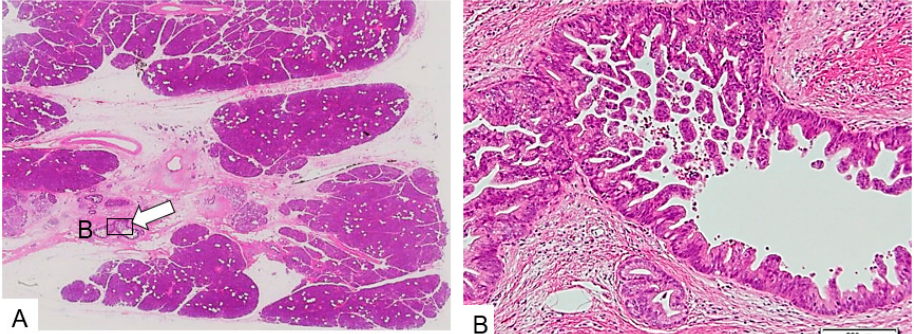
Figure 5. Hypoecho stricture type. ( A ) Histopathological specimen does not show the severely collapsed main pancreatic duct (arrow). Surrounding parenchyma becomes atrophic and is partially replaced by fat tissue. The main and the branch pancreatic duct with epithelial papillary growth is surrounded by fibrous stroma. ( B ) High.power microscopic view reveals the papillary growing epithelium as CIS. (H.E., ×100). Copyright information © Japanese Society of Gastroenterology 2017